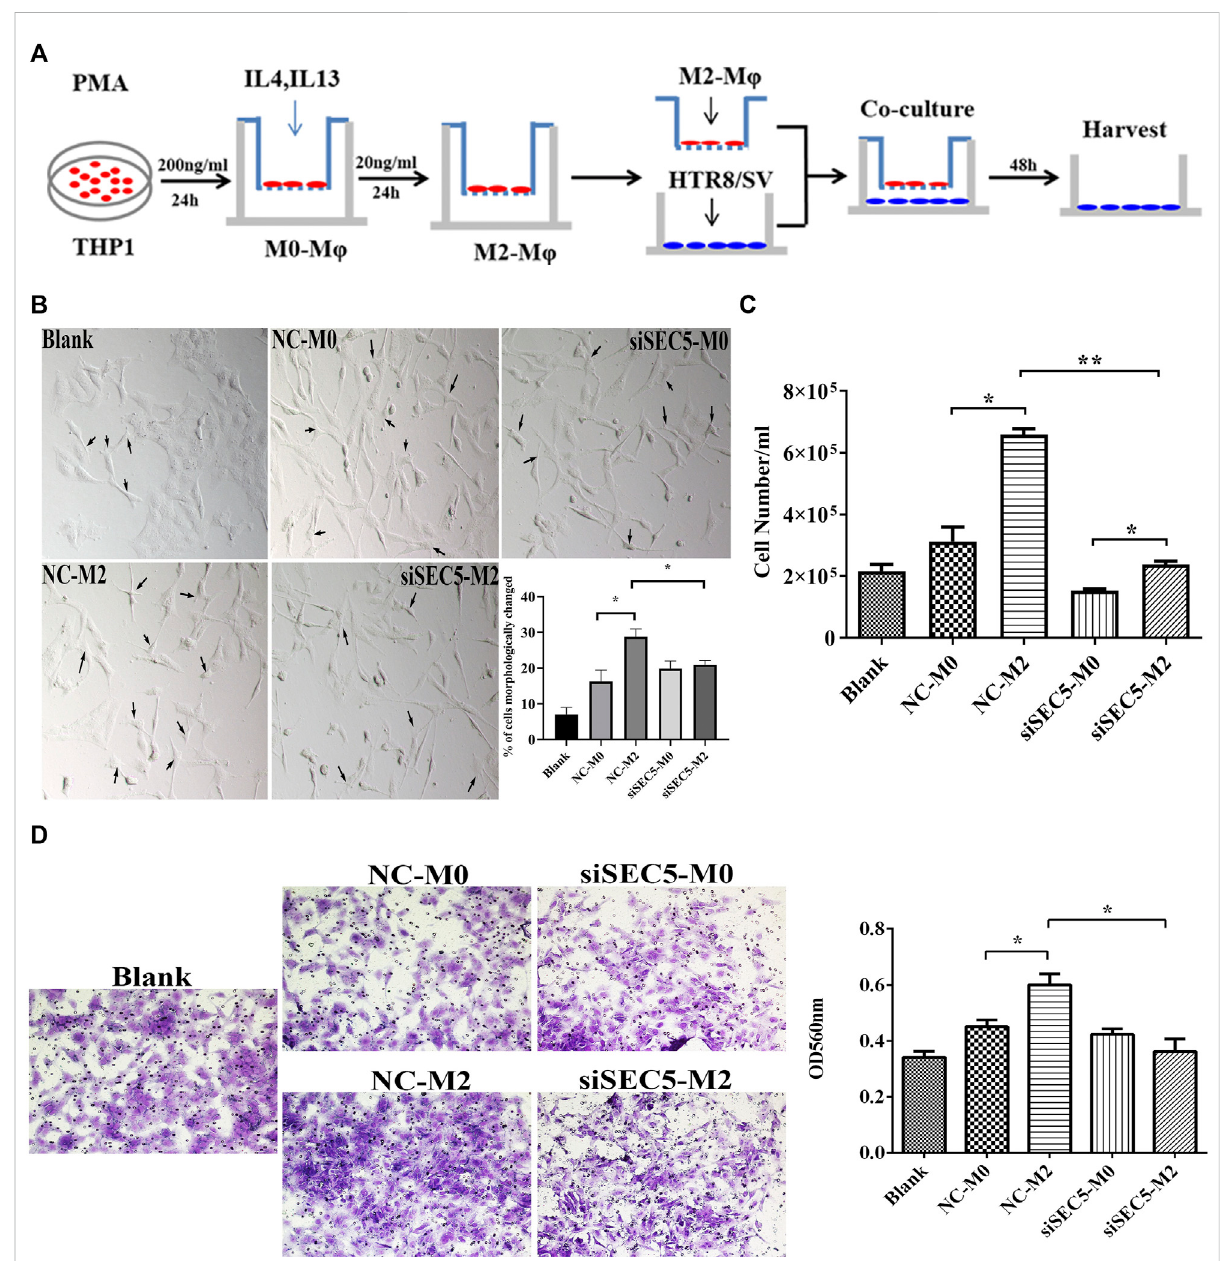
FIGURE 5 Downregulation of SEC5 expression reverses the stimulatory effects of M2-M ϕ s on EVTs. (A) Schematic diagram of the coculture model of THP1-derived M ϕ s and HTR-8/SVneo cells. (B) Representative bright fi eld images of cultured HTR-8/SVneo cells and statistical results showing the percentage of cells with morphological changes (cells in a total of 3 independent fi elds of view were counted in each group, for a total of at least 300cells). (C) ProliferationofHTR-8/SVneocellsdetectedwithcellcountingassays. (D) InvasionofHTR-8/SVneocellsdetectedwithTranswell assays. Left: Representative images of a Matrigel invasion assay with crystal violet staining; Right: statistical analysis (based on the OD values at 560 nm) of the cells in each Transwell assay group that were stained after invasion and dissolved in methanol. Blank: HTR-8/SVneo cells were cultured in medium; NC-M0: HTR-8/SVneo cells were cocultured with M0-M ϕ s transfected with NC; siSEC5-M0: HTR-8/SVneo cells were cocultured with M0-M ϕ s transfected with SEC5-speci fi c siRNA; NC-M2: HTR-8/SVneo cells were cocultured with M2-M ϕ s transfected with NC; siSEC5-M2:HTR-8/SVneocells werecoculturedwith M2-M ϕ stransfected with SEC5-speci fi cshRNA. All experiments wereindependently repeated at least 3 times. * p < 0.05, ** p <